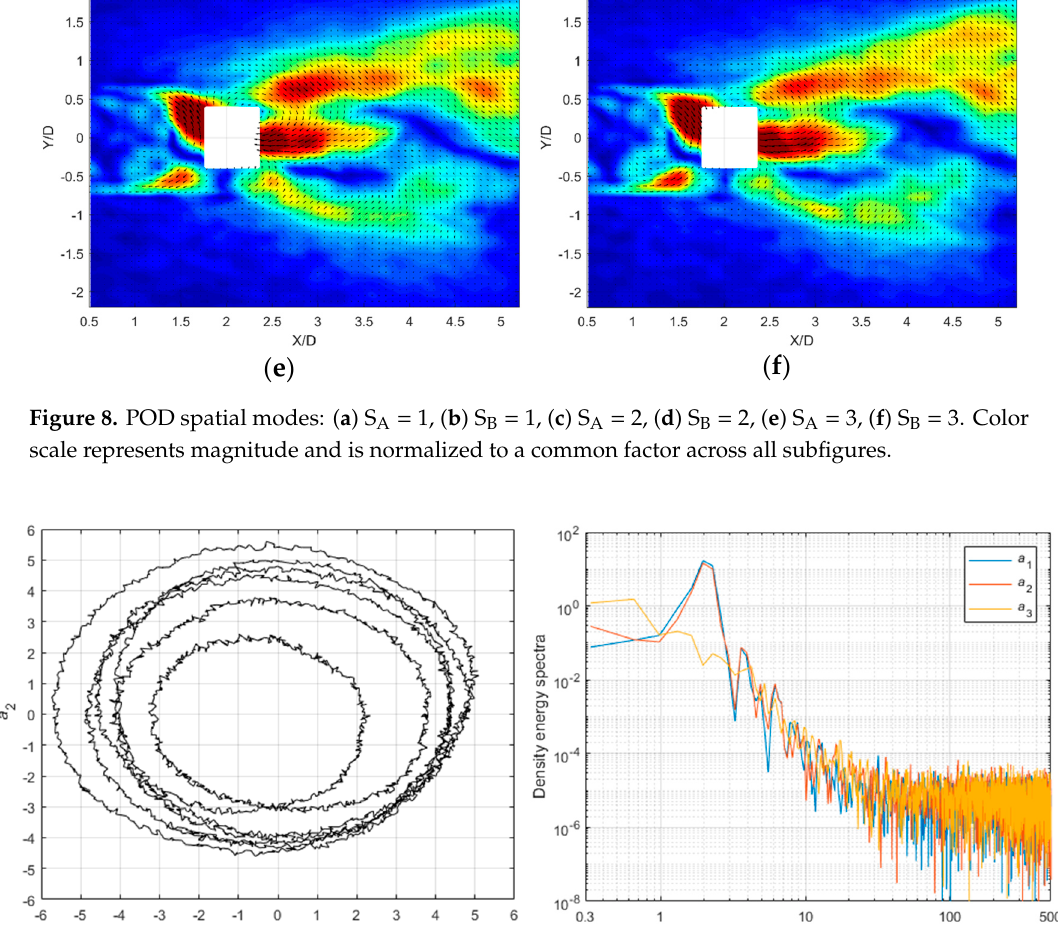
Figure 9. POD temporal coefficient analysis for early modes. ( a ) First, a 1 and second, a 2 temporal coefficients; ( b ) Spectral energy content for the first three sets of temporal modes.